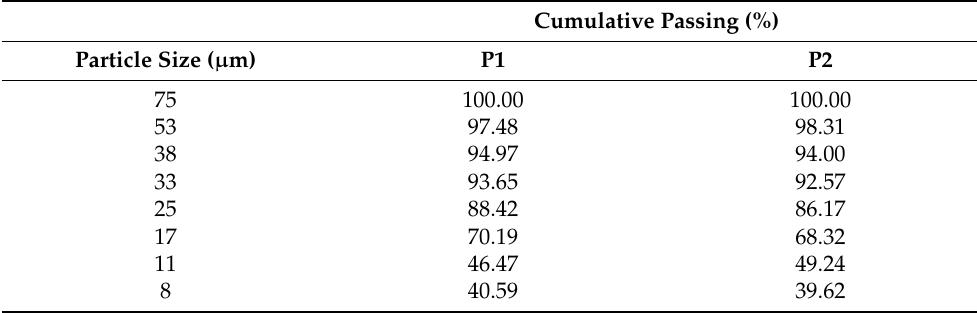
Table 8. The variation in the product size distributions of different breakage functions given in Figure